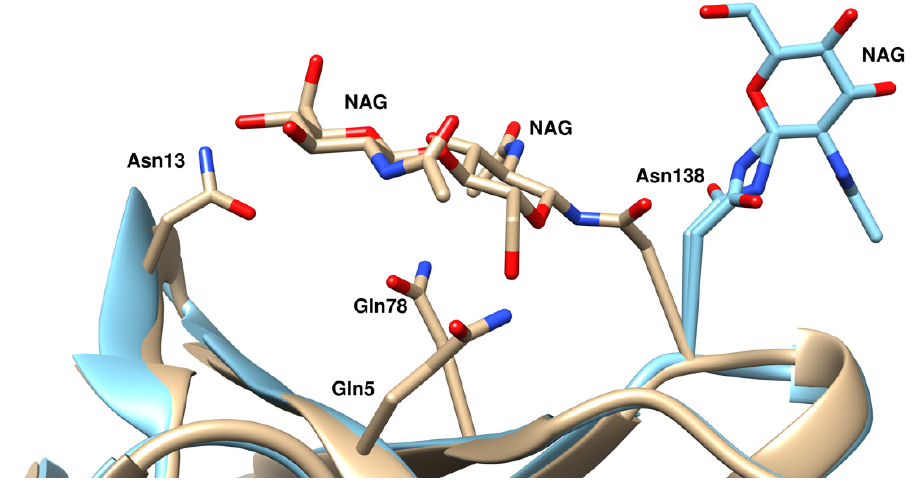
Figure 7. Glycosylation at Asn138. n Ta AA9A is depicted in brown, and r Ta AA9A in cyan.